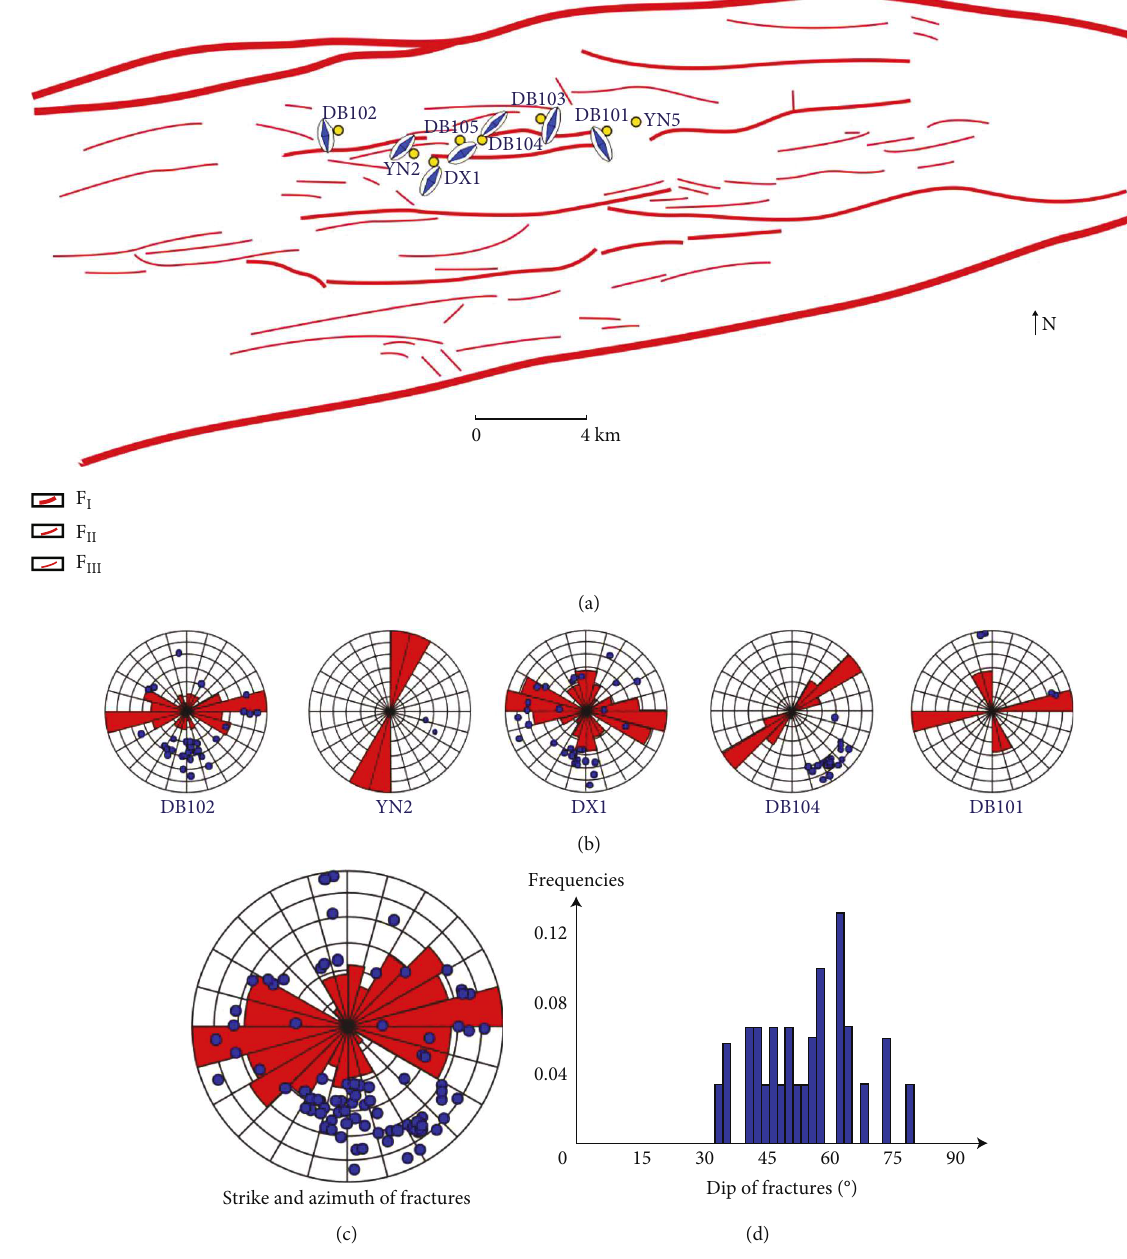
Figure 11: Orientation of S